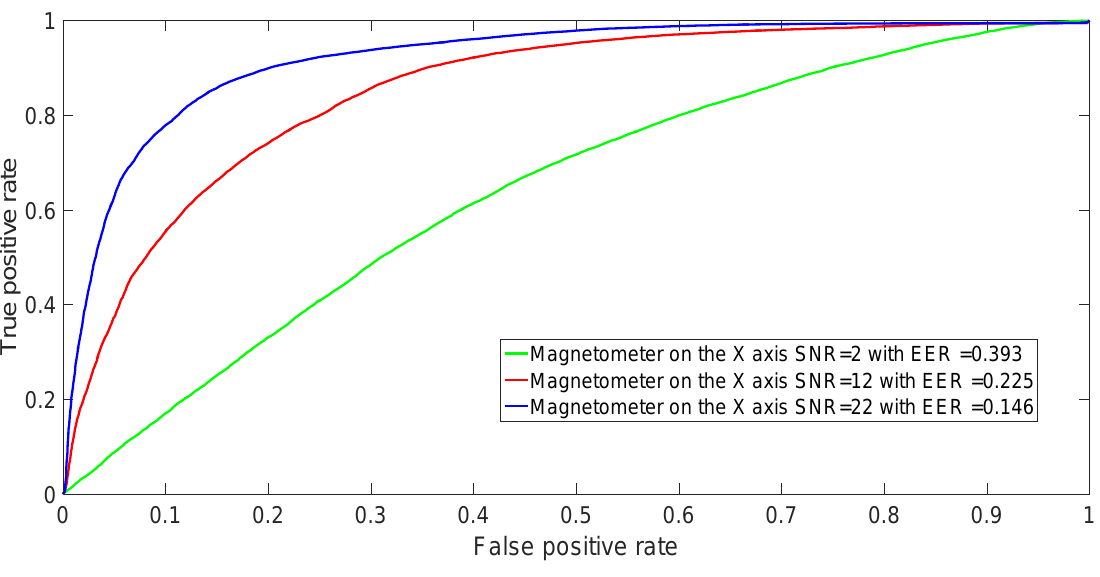
Figure 11. ROC achieved by SVM in binary classification between Sony Xperia X and Samsung Galaxy S7 using the X -axis for decreasing values of SNR. Again, these curves are obtained after averaging over 50